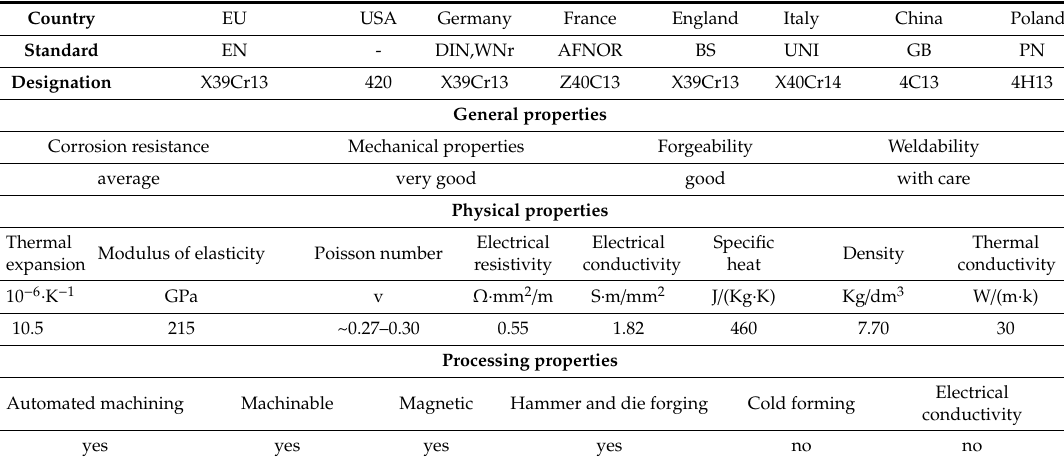
Table 3. Selected properties of X39CR13 high carbon martensitic stainless